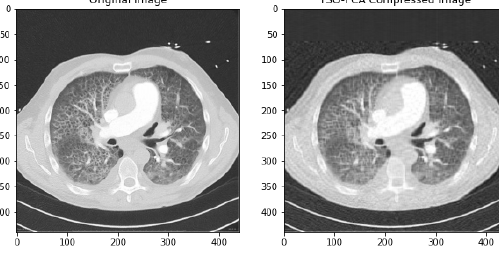
Figure 3. Original Image and TSO-PCA Compressed Image